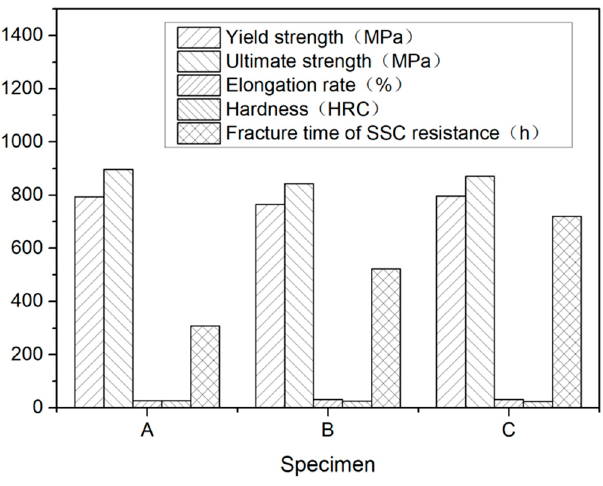
Figure 5 . Mechanical properties and fracture time of SSC testing . Figure 5. Mechanical properties and fracture time of SSC testing.